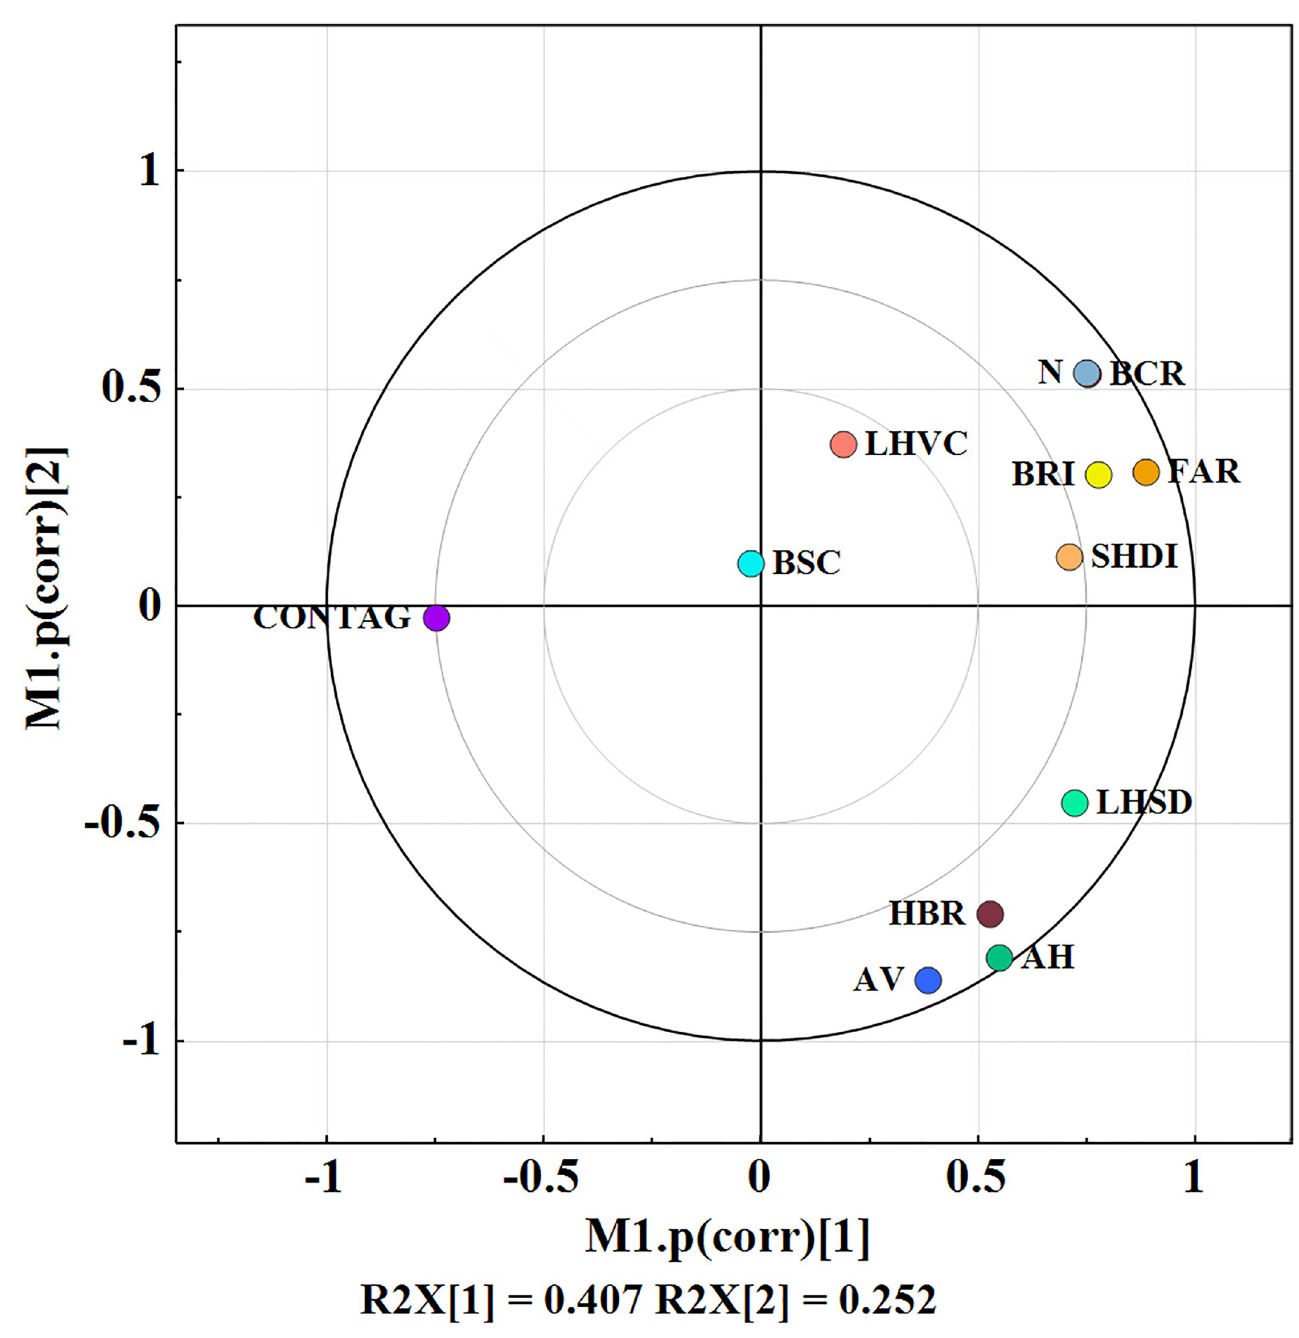
Fig 5. Load plot of